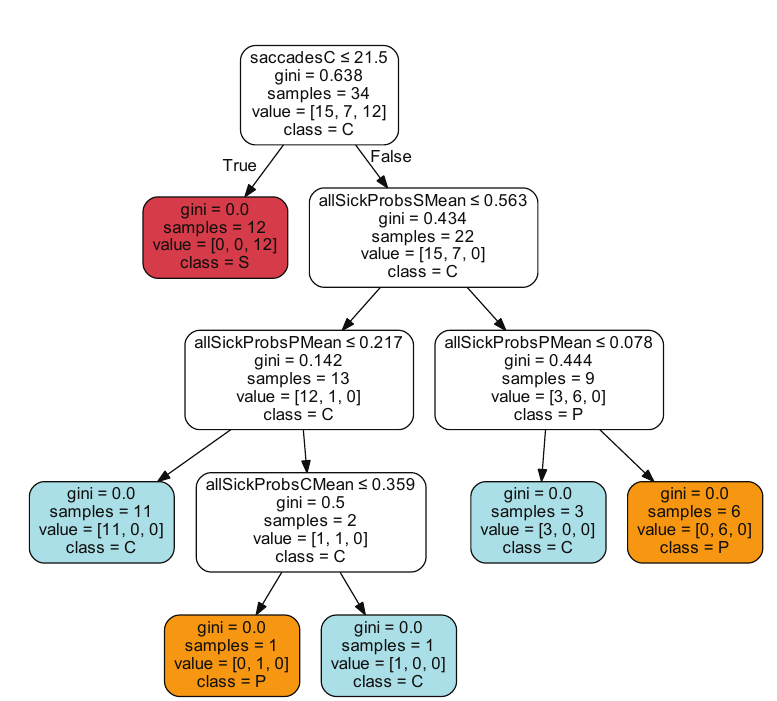
Figure 7. Illustration of the decision tree model obtained from the validation data in one of the repeated runs. Figure 8 shows how a presymptomatic register is mistaken as control by another DT.